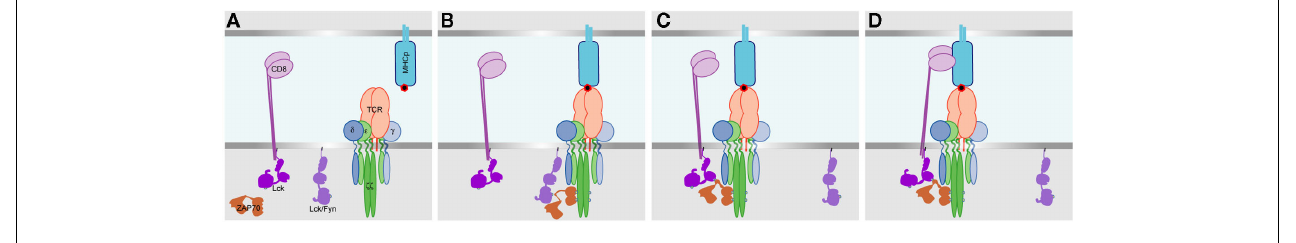
phosphorylates CD3 ζ ITAMs and then ZAP70 which binds to the phosphorylated CD3 ζ ITAMs. (C) The SH2 domain of CD8 bound Lck then interacts with the phospho-ZAP70, pulling CD8 into proximity with the MHCp-interactingTCR. (D) The extracellular immunoglobulin domains then bind to the MHCp, stabilizing theTCR–MHCp